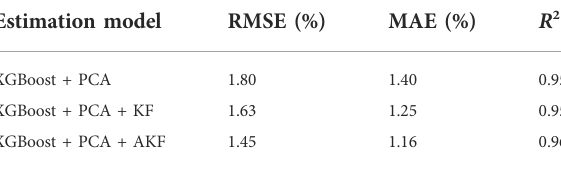
FIGURE 9 Comparison of the relative errors of XGB and XGB-KF model test sets.